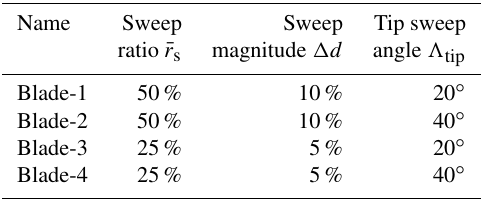
Table 3. The parameters of the planforms of four backward swept blades (Li et al.,